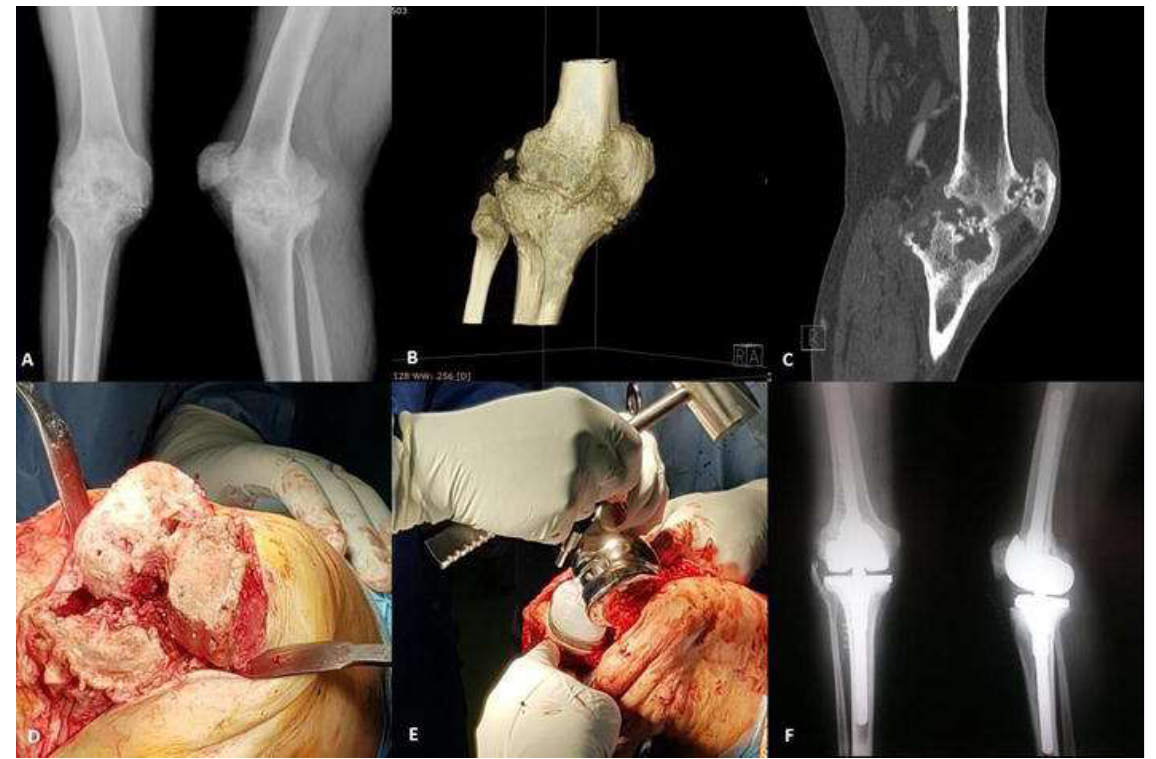
Figure 2. Total knee replacement in a haemophilic patient receiving concentrate replacement therapy. ( A ) Severe right gonarthrosis with bilateral genu valgum, more visible on the right side. ( B ) Typ- ical shape and structure modifications for a haemophilic knee arthropathy (widening of the tibial plateau, tibial condyle hypertrophy, accentuation of the intercondylar incision with modification of the tibial spines and obvious rarefaction of the geodesic structure. slight collapse of the right internal tibial plateau). ( C ) periarticular osteolytic lesions with interruption of the cortex at the level of the tibial plateau and the condyles of the femur and at the level of the posterior patellar surface, with sclerotic edges and subcortical cysts.; narrowing of the femoral-tibial joint space until complete disappearance ( D ) and ( E ). Total knee arthroplasty for severe haemophilic arthropathy using a revision modular prothesis “rotating-hinge” type-intraoperative images. ( F ) Right knee total arthroplasty-intraoperatively front and lateral